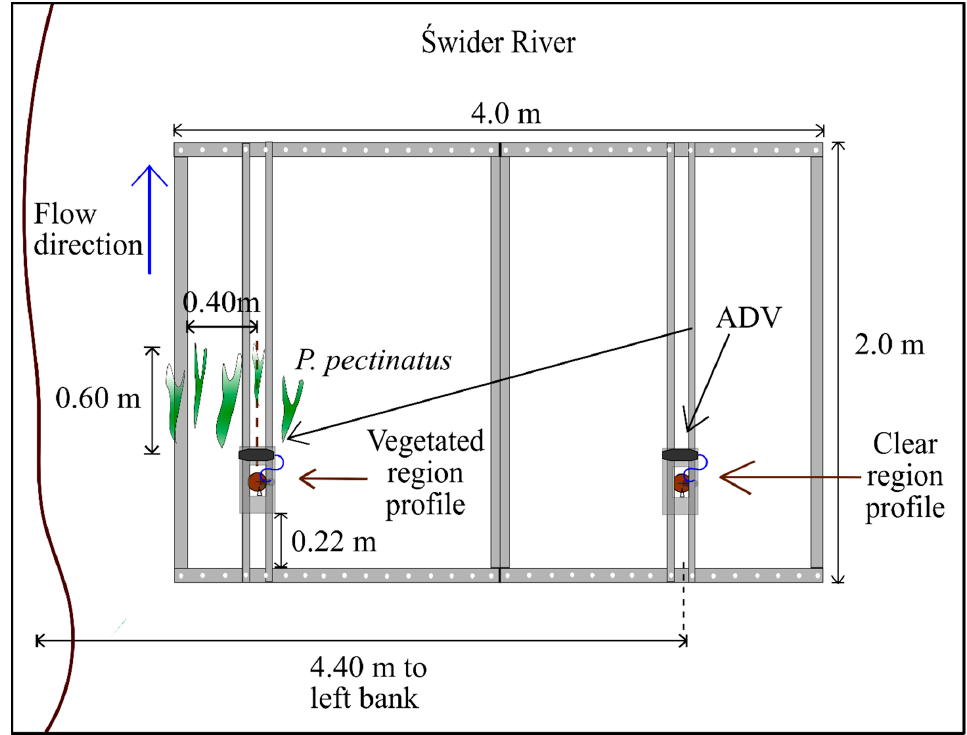
Figure 3. Arrangement of the platform with Vectrino Profilers and individuals of P. pectinatus during the experiment in the Ś wider River.